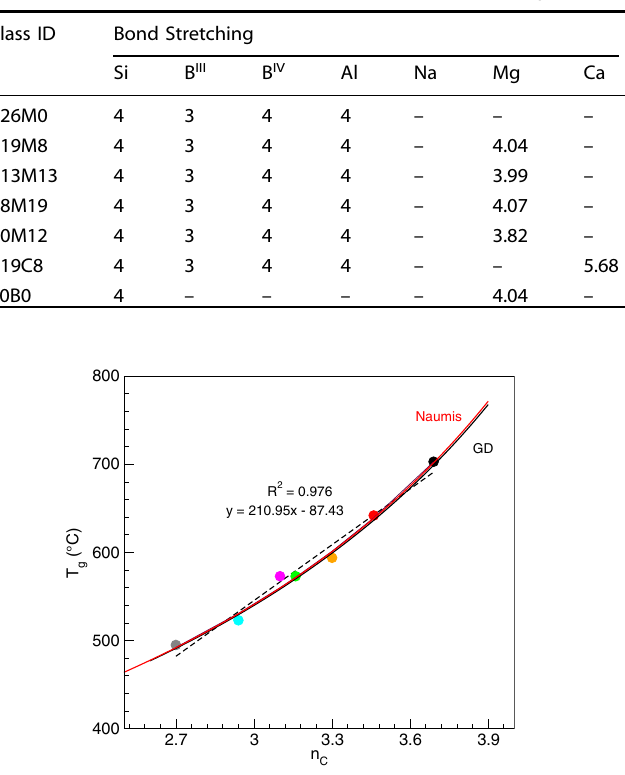
Table 3. Number of BS and BB constraints per element for all glasses depending on their composition.